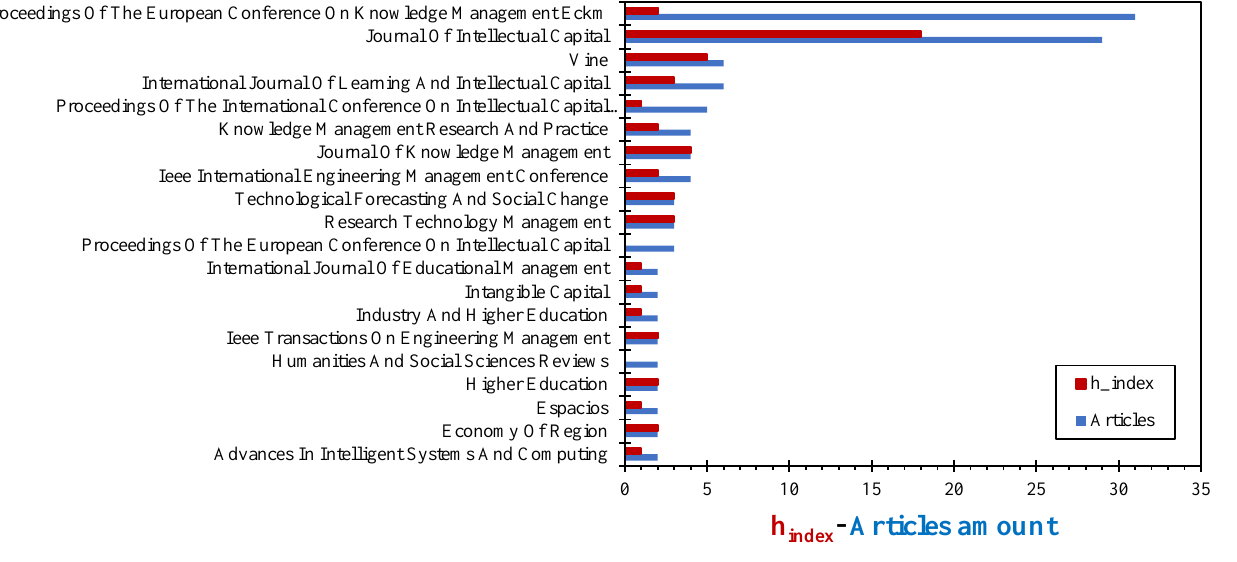
Figure 8. Importance of the 20 main sources.